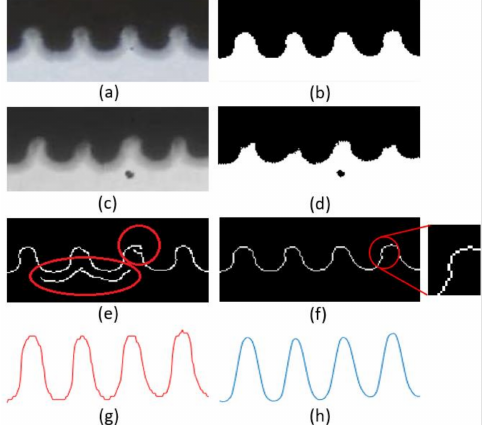
Figure 6. Projection of the drum rope arrangement boundary. ( a ) and ( c ) are the original projection of the projection edge of the drum rope arrangement; ( b ) and ( d ) are, respectively, binary images of ( a ) and ( c ); ( e ) and ( f ) are figures after edge recognition by the Canny algorithm; ( g ) is the contour curve obtained by the method proposed in this study and ( h ) is the result of graph ( g ) after smoothing